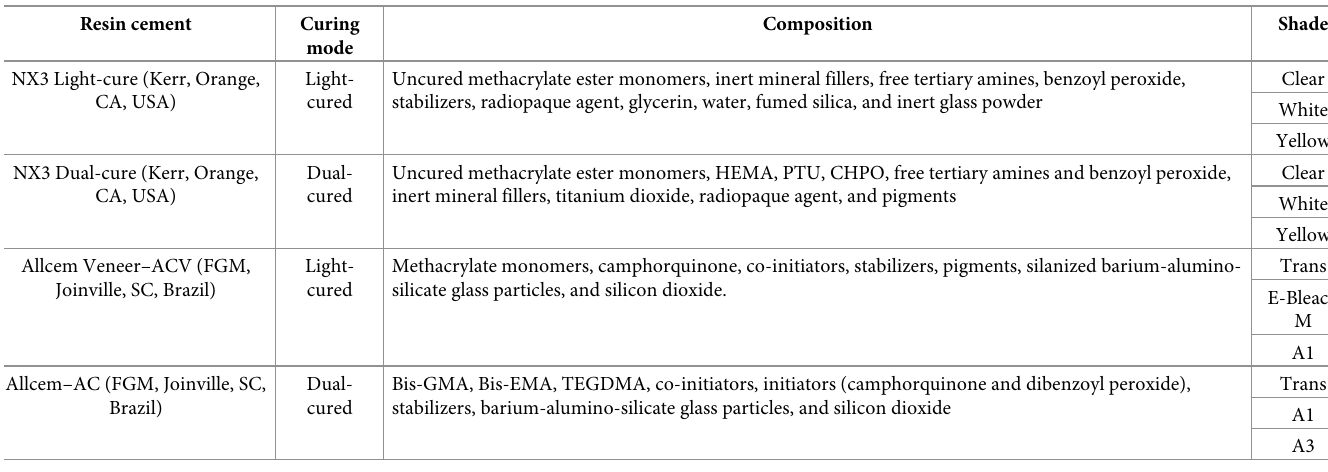
Table 1. Curing mode, shades, and composition of the resin